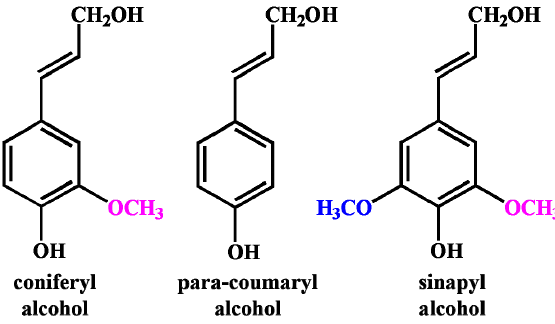
Figure 1. Three monomer structures of lignin.